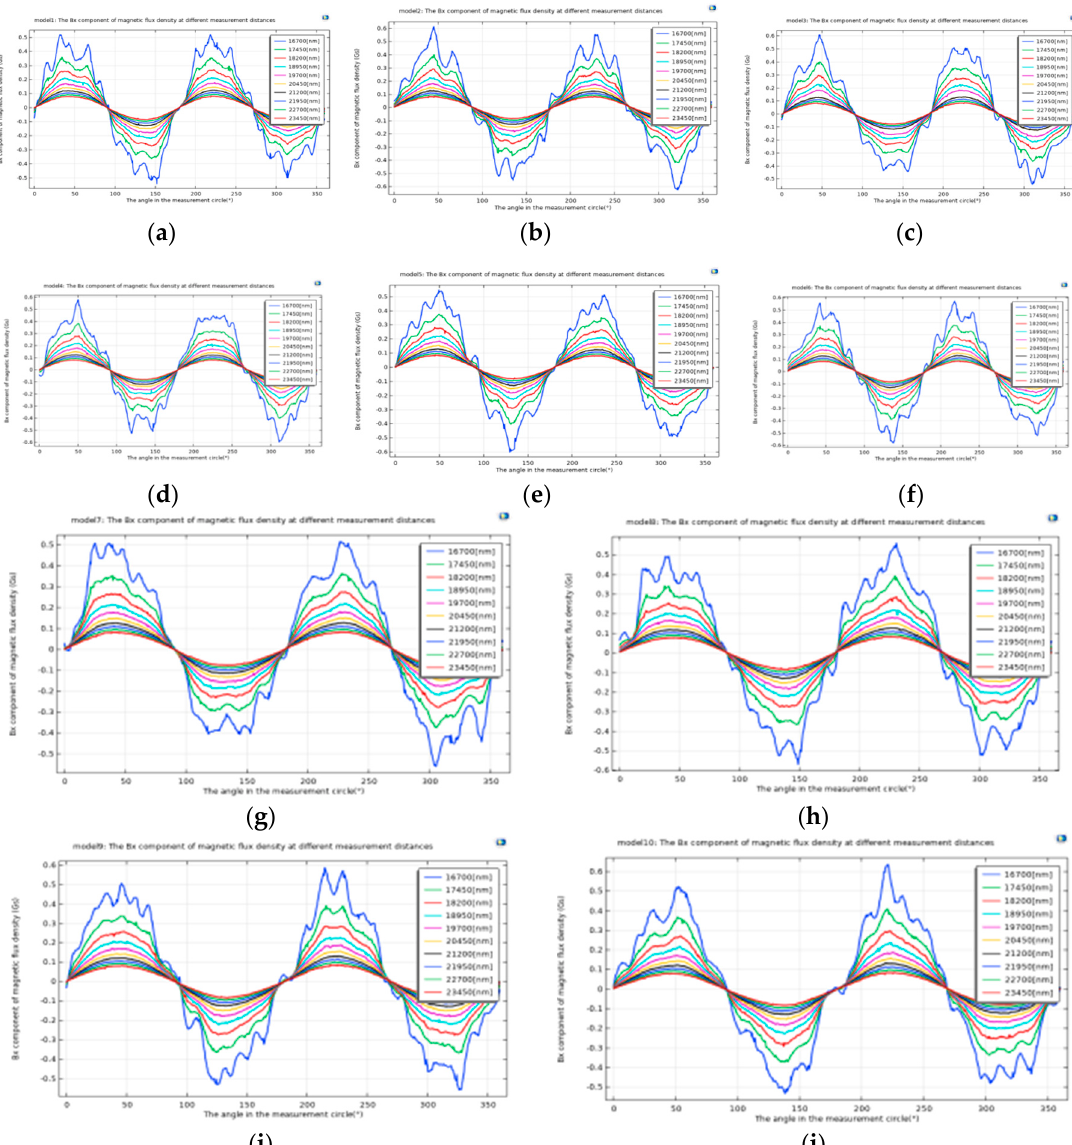
Figure 8. The Bx component results of model1–model10 obtained at different measurement distances: ( a )–( j ) the Bx component results of model1–model10, respectively.